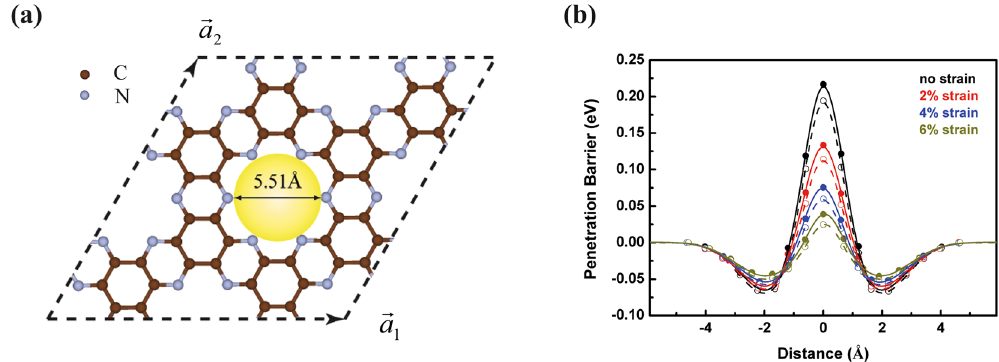
→ → a 1 , a 2 represent two primitive